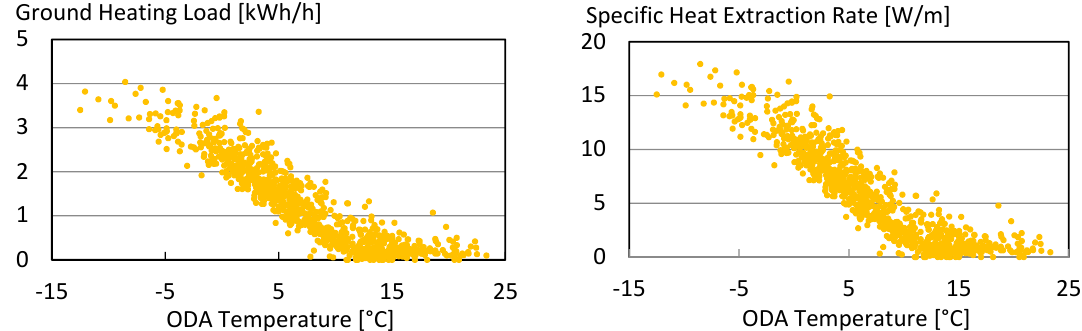
Figure 30. Hourly ground heating loads ( left ) and specific ground heat extraction rates ( right ) as a function of outdoor air temperatures.